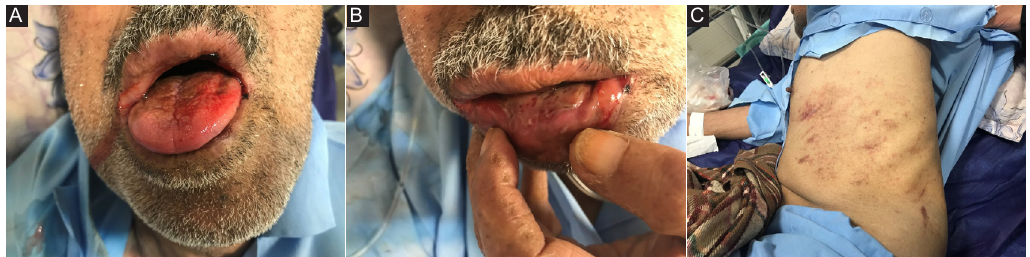
Figure 2. (A) Mucocutaneous, (B) mucocutaneous and (C) cutaneous lesions in case number